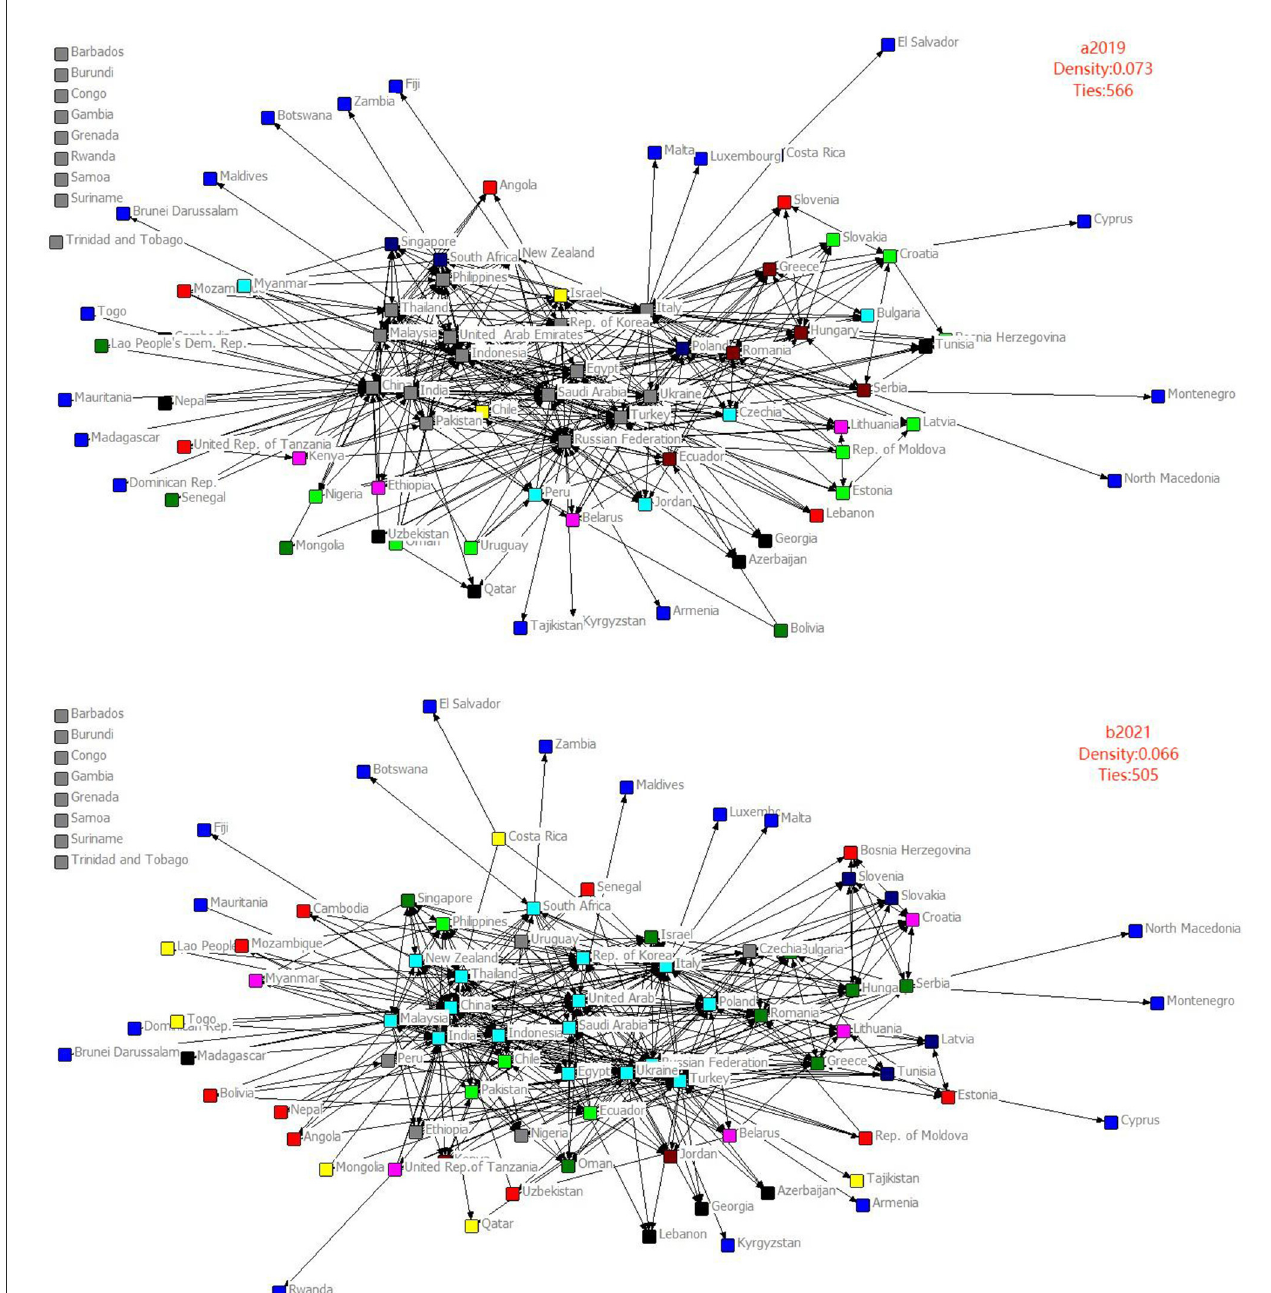
FIGURE1 Evolution diagram of agricultural products trade network pattern of countries along the B&R in 2019 & 2021.